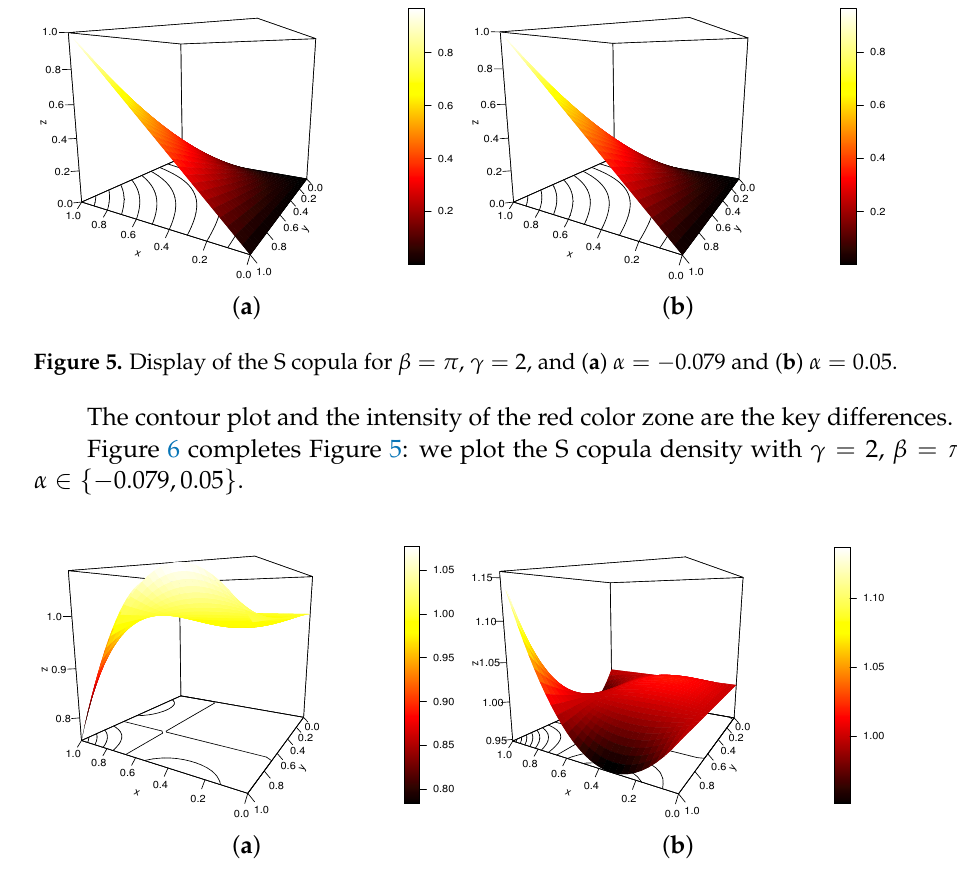
Figure 6. Display of the S copula density for β = π , γ = 2, and ( a ) α = − 0.079 and ( b ) α =